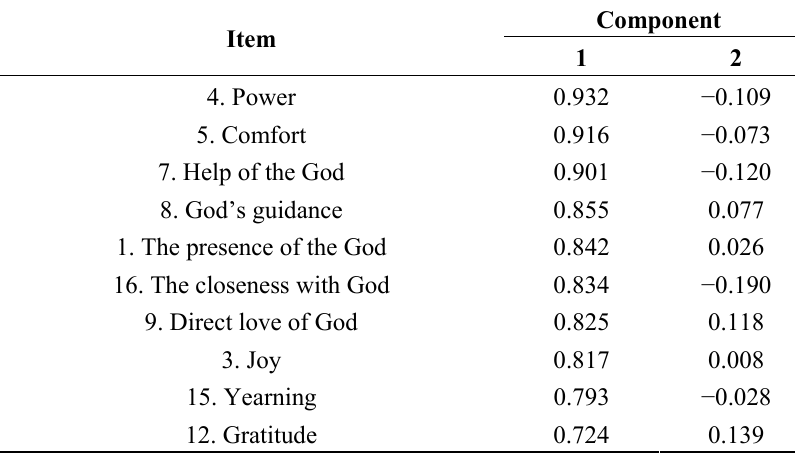
Table 5. Overview of the structure of the form (pattern matrix) after oblique rotation.